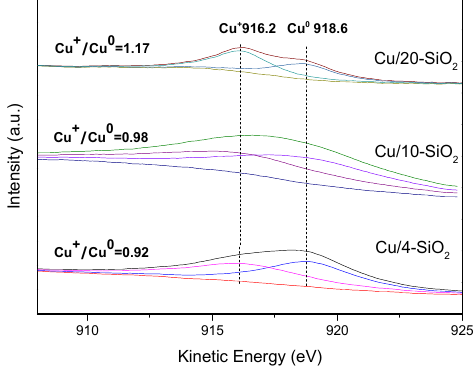
Figure 6. Cu LMM XAES profiles of reduced Cu/ x -SiO 2 catalysts.